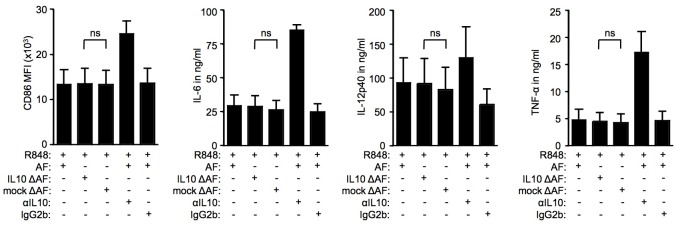
Depletion of IL-10 from OC-associated ascites does not release the suppression of TLR-mediated DC activation.Monocyte-derived DC were stimulated with 3μg/ml R848 in the presence or absence of 10% ascites from ovarian carcinoma patients which had previously been depleted of IL-10 (IL10 ΔAF) or which had undergone mock depletion (mock ΔAF). Alternatively, DC cultures were treated with R848 and untreated ascites (AF) in the presence of αIL-10 neutralizing antibody or isotype control antibody (5μg/ml); n = 3 (3 independent experiments; monocyte-derived DC from 1 healthy donor, cultured with three ascites samples from three individual ovarian carcinoma patients). IL-6 levels were measured in cell culture supernatants by sandwich ELISA.